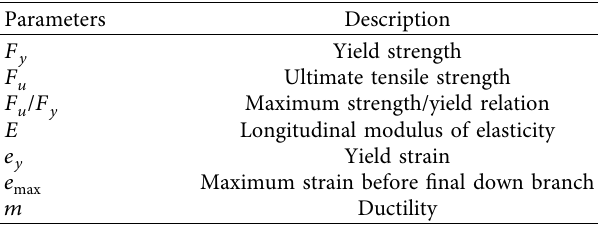
Table 1: Steel parameters are